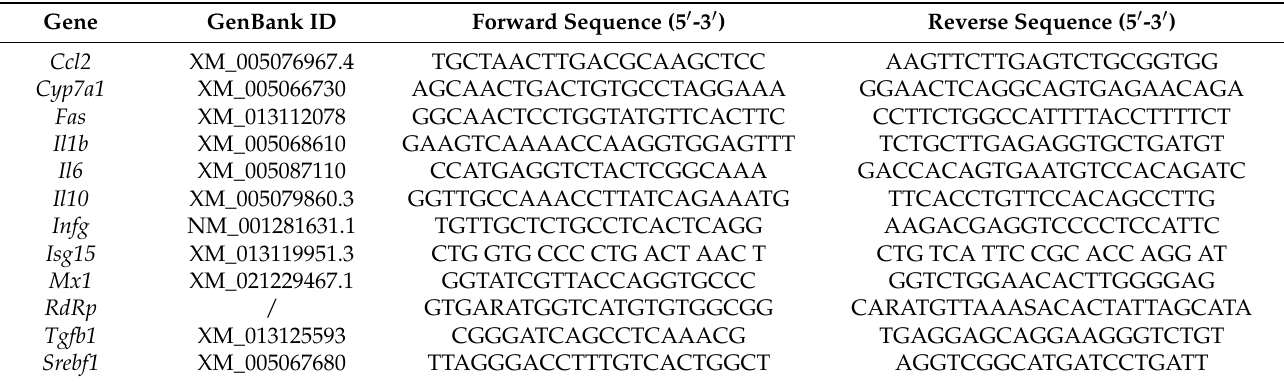
Table 1. The qPCR primer